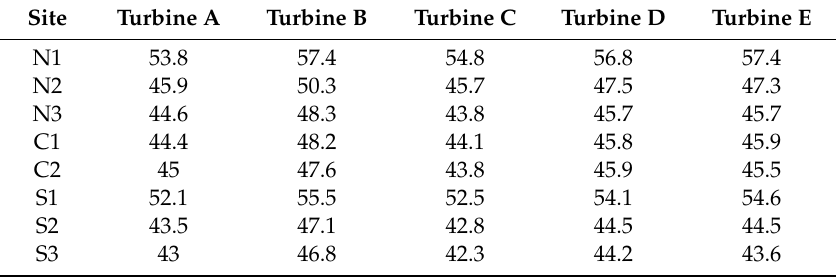
Table 6. The enhancement in the percentage of the number of wind turbines considering as reference the emissions from the years 2010 (with the lowest values) and 2019 (with the highest values).